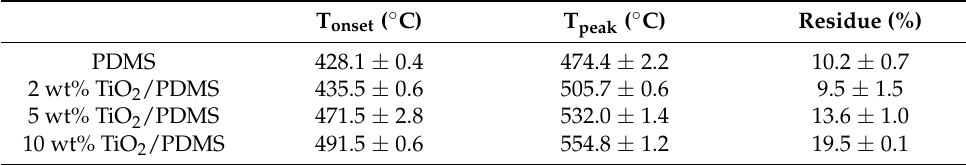
Table 2. TGA results of PDMS and TiO 2 /PDMS